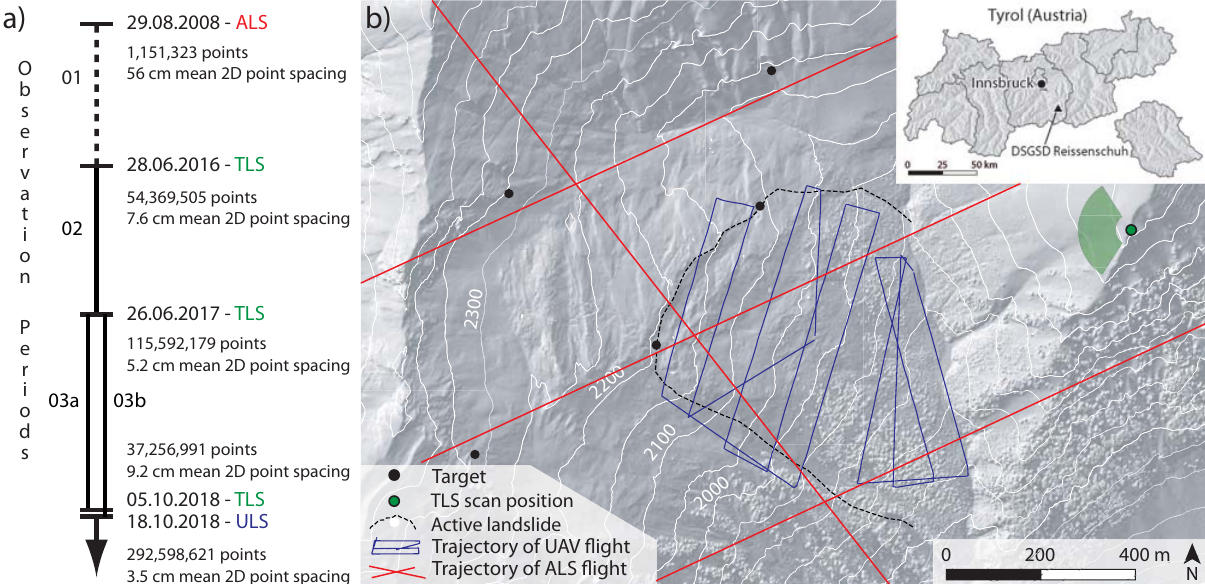
Figure 1. a) Laser scanning datasets with respective characteristics and acquisition dates indicating three observation periods. b) Location of the Reissenschuh landslide in the province of Tyrol, Austria and illustrated description of the laser scanning acquisition